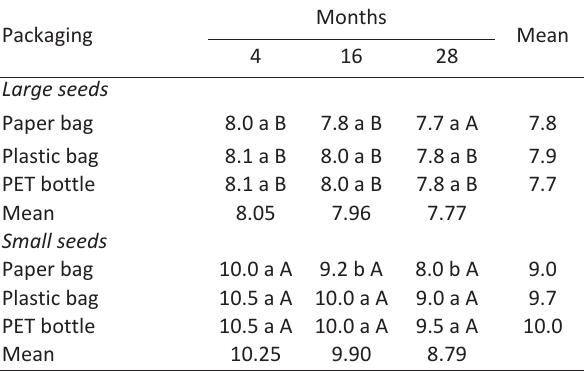
In the column, means followed by different letters, lowercase letters between packages and uppercase between sizes, differ by Tukey test at